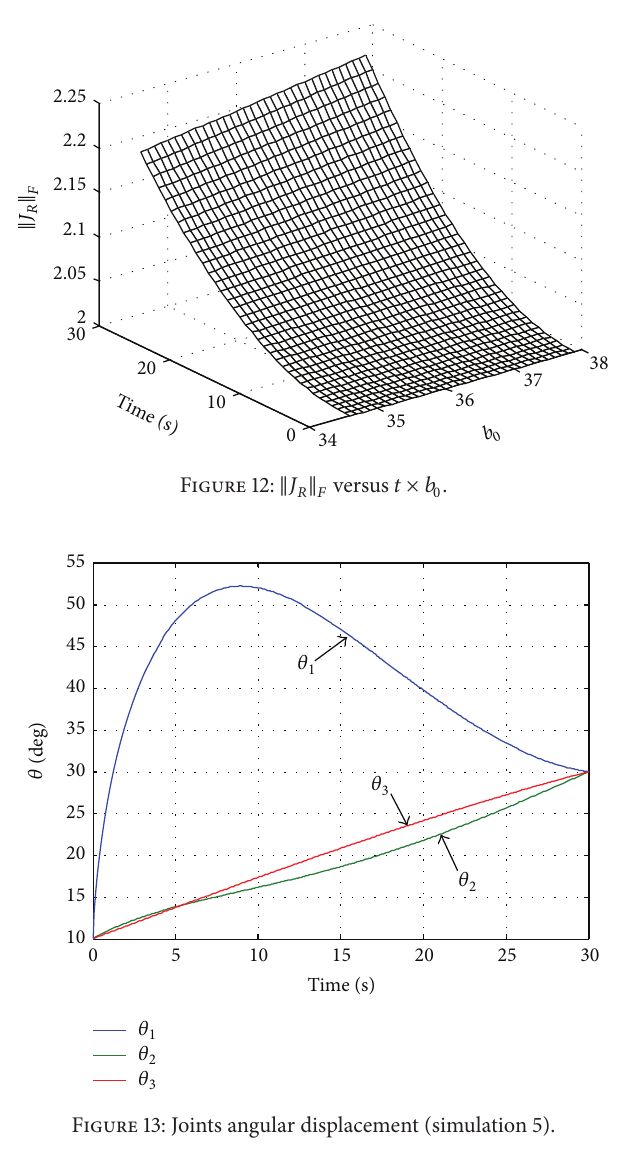
Figure 13: Joints angular displacement (simulation 5).